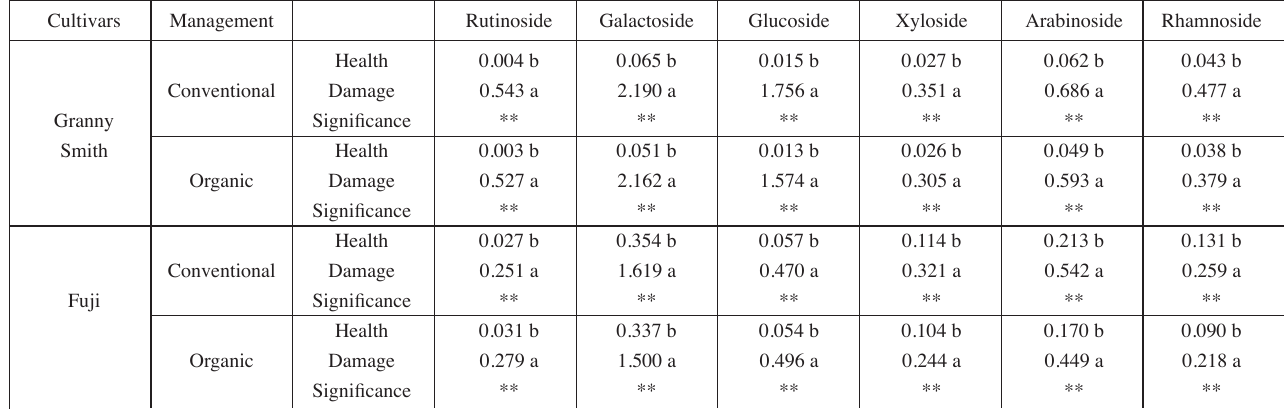
Tab. 5: Concentration of quercetin glycosides in cv. Granny Smith with different sunburn damage level. Cultivars